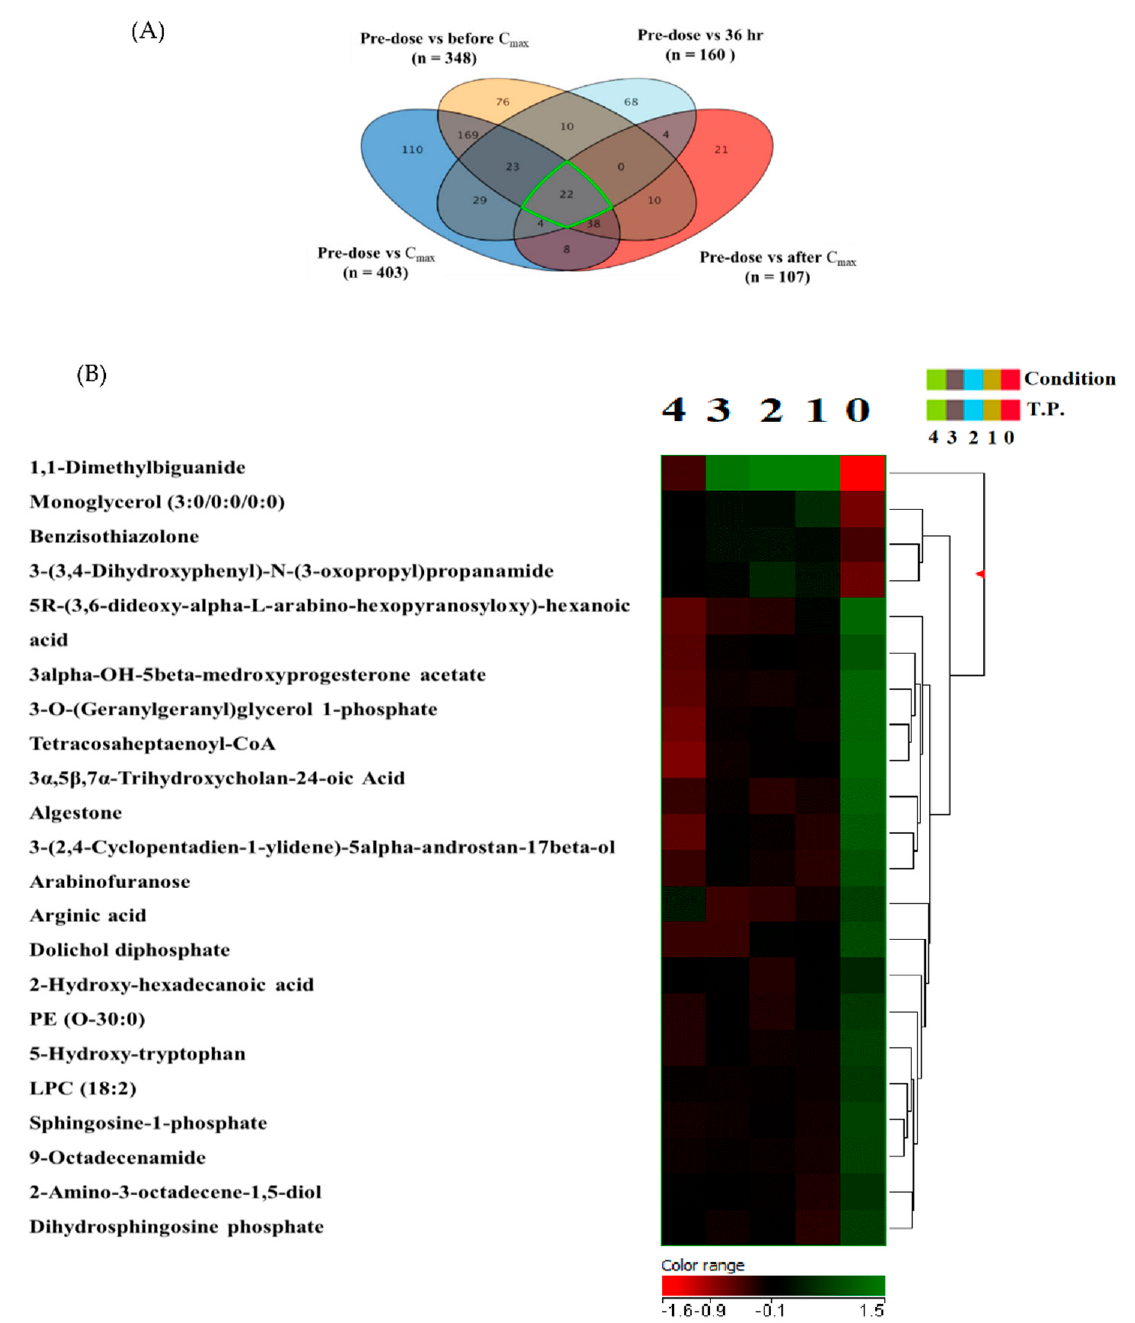
Figure 2. Significantly altered lipids between the post-metformin administration time points com- pared to the predose sample (baseline level). ( A ) A Venn diagram illustrating the overlap between the post − metformin administration time points (before C max , C max , after C max , 36 h) compared to the predose sample with the number of significantly altered lipids ( n ). A group of 22 features, including metformin, are consistently dysregulated within the five − ime points. Data were analyzed using one-way ANOVA using Tukey’s post hoc analysis. ( B ) Heatmap and hierarchical cluster analysis of 22 features dysregulated between the four − time points after metformin administration and predose sample. Time points 0, 1, 2, 3, and 4 refer to baseline, before C max , C max , after C max and 36 h post − metformin administration. Metformin is 1,1-Dimethylbiguanide.